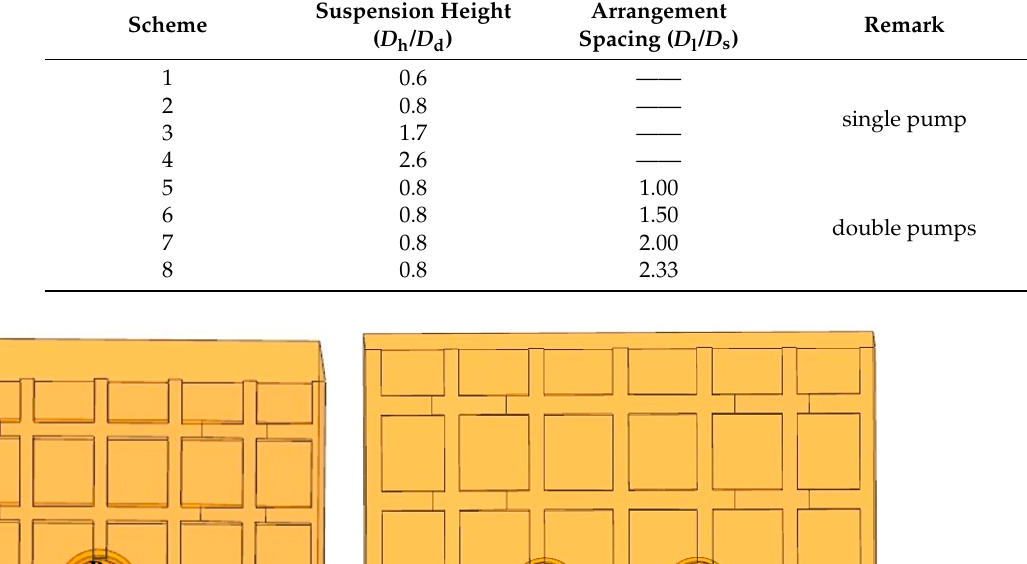
Table 2. Research schemes of different suspended heights.